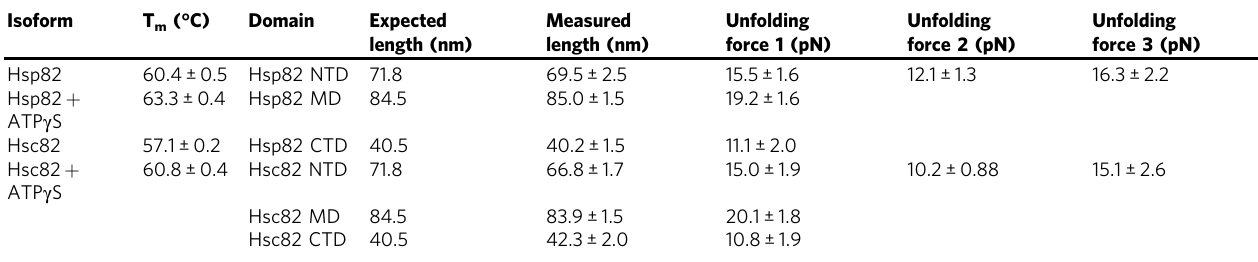
Melting temperatures ( T m ) of the Hsp90 isoforms were determined by tracking SYPRO orange binding upon thermal unfolding in the absence or presence of ATP γ S. Means of three technical replicates andstandard derivationare shown. Todetermine the mechanicalstabilityof the Hsp90 domainsof the isoforms opticaltrapping experimentswereperformed at 30°Cand the expectedgains incontour length were compared with the measured gains in contour length. The indicated domains were pulled at different speeds and the average unfolding forces are indicated: Unfolding force 1: average unfolding force at 500nm/s, unfolding force 2: average unfolding force at 20nm/s, unfolding force 3: average unfolding force at 20nm/s in the presence of 10 µ M RD. Average forces and SD were calculatedfrom samplesizes of: 426eventsand132 eventsforunfoldingforce 1 forHsp82andHsc82,respectively; 82eventsand38 events forunfoldingforce 2forHsp82and Hsc82,respectively;and 16 events and 34 unfolding events for unfolding force 3 for Hsp82 and Hsc82,